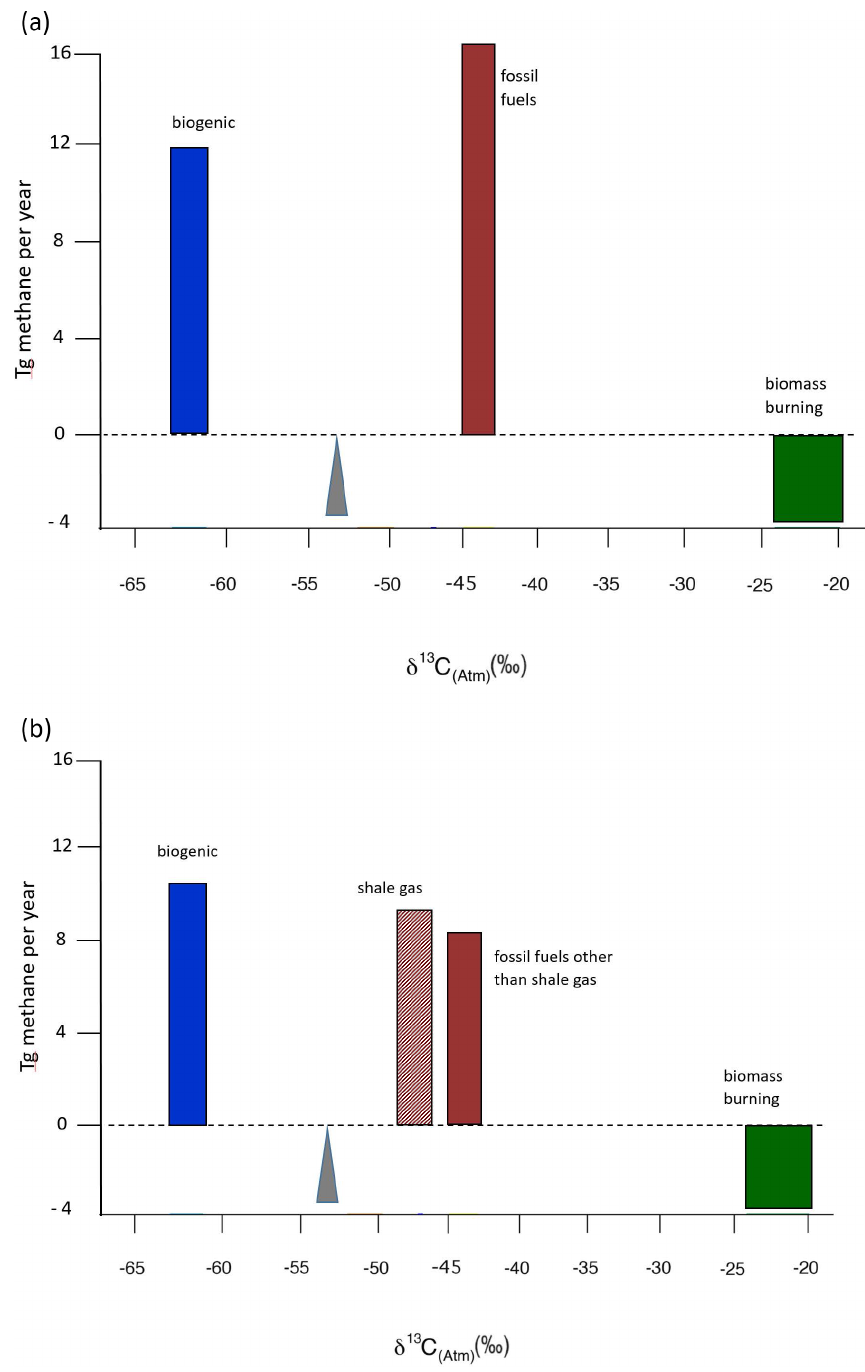
Figure 3. (a) On the x axis, δ 13 C values for methane from biogenic sources, fossil fuel, and biomass burning as presented in Worden et al. (2017) for values from Schwietzke et al. (2016); width of horizontal bars represents the 95% confidence limits for these values. Triangle indicates the flux-weighted mean input of methane to the atmosphere. The y axis shows mean estimates from Worden et al. (2017) for the increase and decrease in methane emissions from particular sources since 2007 as calculated using the δ 13 C values of Schwietzke et al. (2016). (b) On the x axis, δ 13 C values as in Fig. 3a, except the value for fossil fuels does not include shale gas and a separate estimate for shale-gas value is included (see text). The y axis indicates estimates developed in this paper for the increase or decrease in methane emissions since